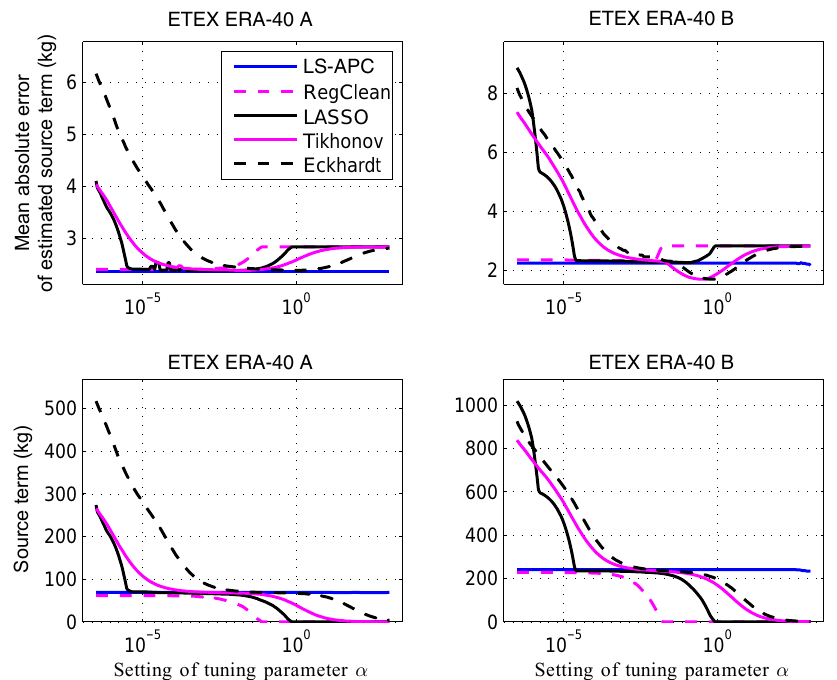
Figure 5. Comparison of sensitivity of the tested algorithms to the setting of the selected tuning parameter α measured in terms of the mean absolute error metric (top row), Eq. (26), and total estimated mass of the source term (bottom row) on data ETEX ERA-40 A and B.